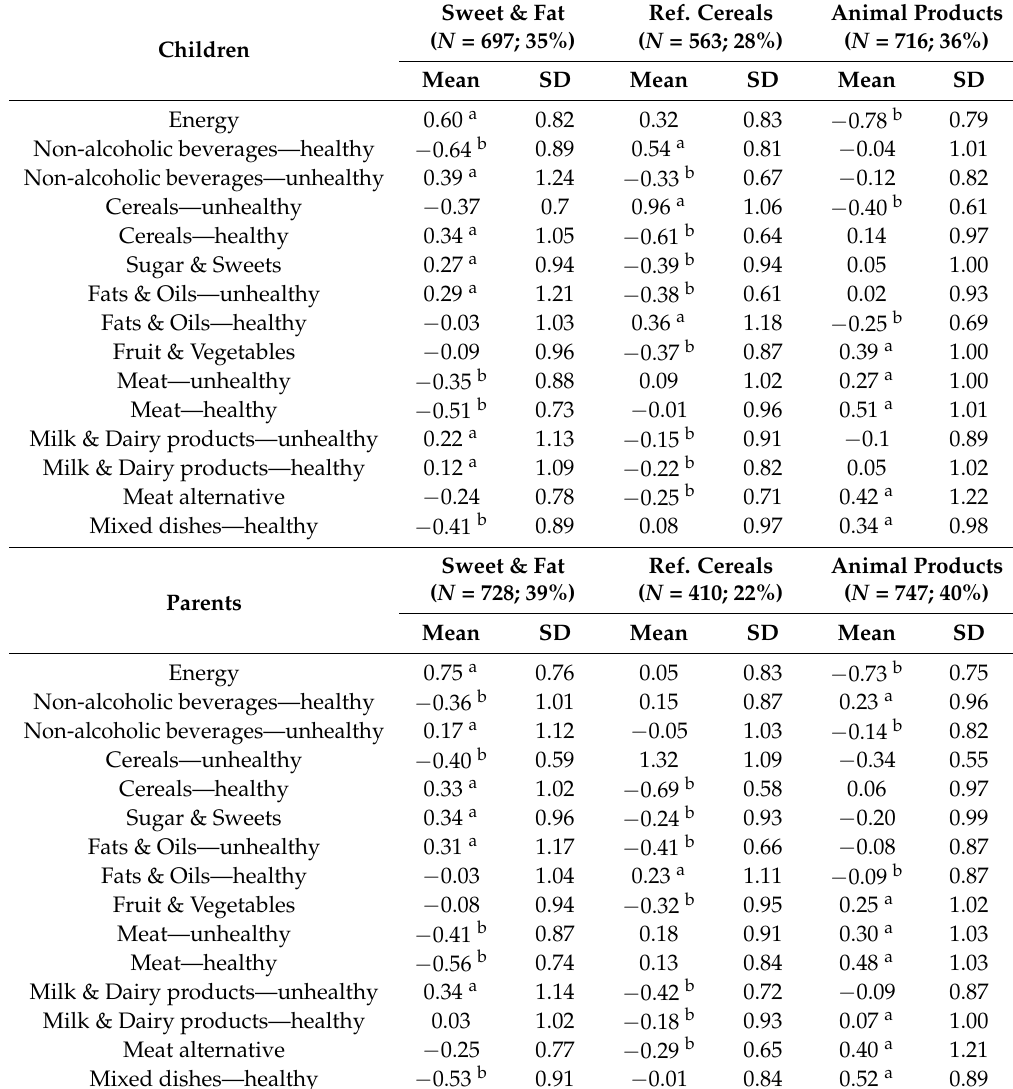
Table 2. z -scores of usual intake in the three clusters for children and for parents (mean values and standard